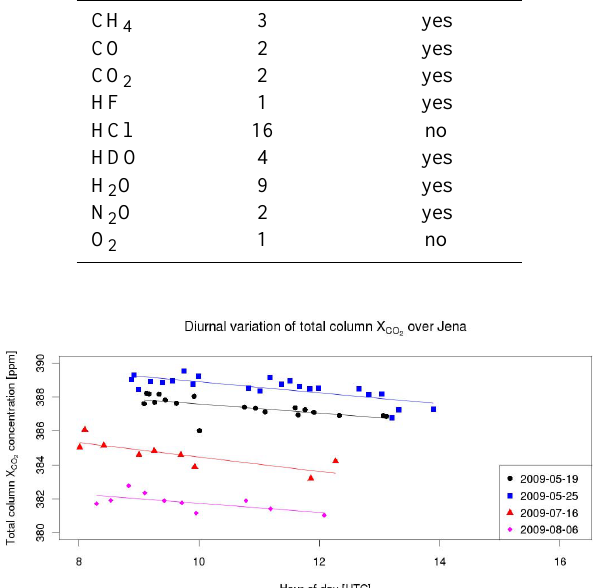
Fig. 13. Diurnal variation of total column X CO on selected days. The decrease of X CO constant.